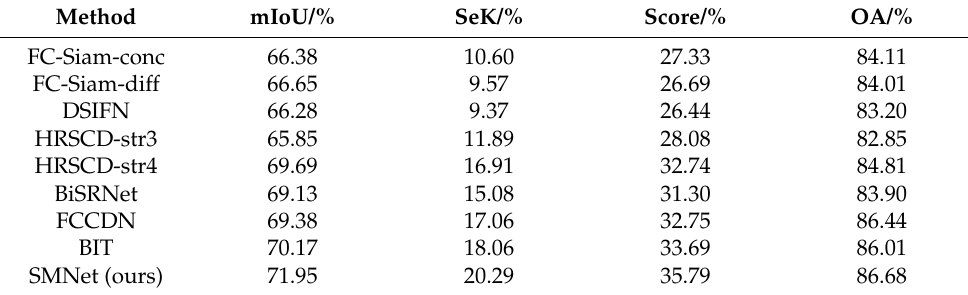
Table 1. Comparison results on SECOND dataset.